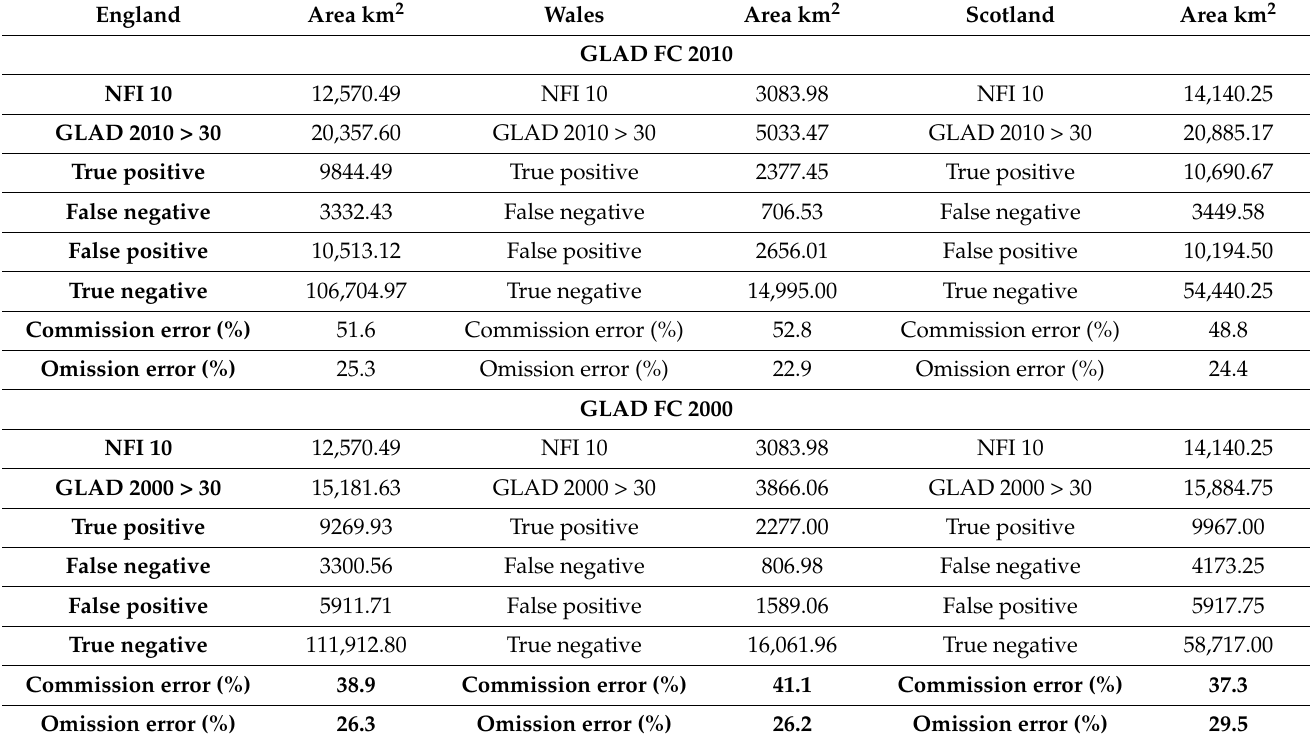
Table 4. Accuracy results of GLAD FC 2000 and